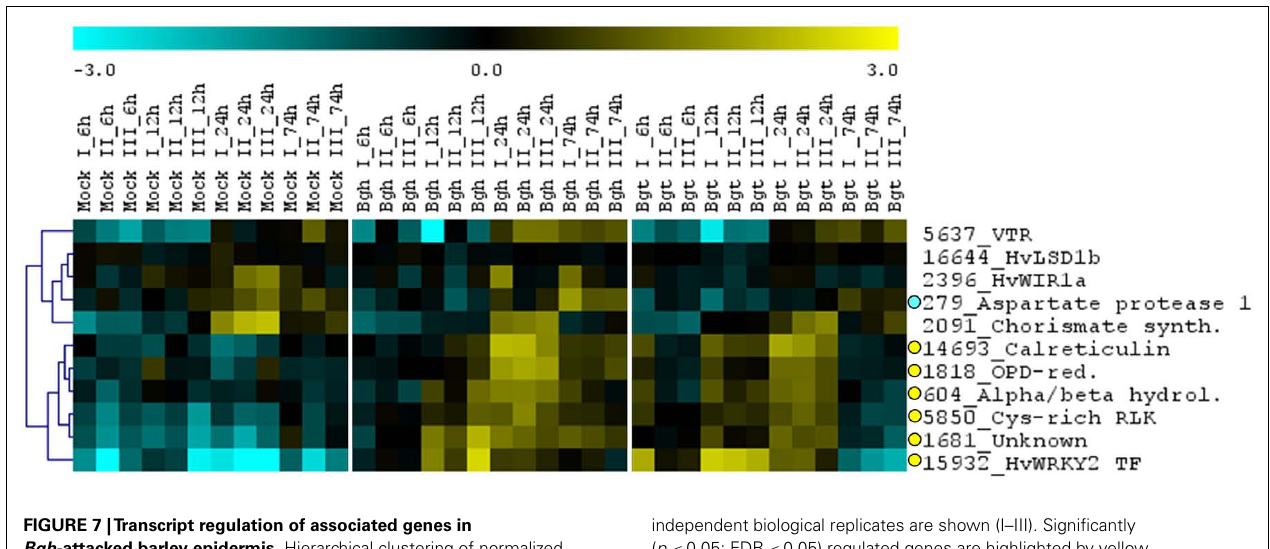
FIGURE 7 |Transcript regulation of associated genes in Bgh -attacked barley epidermis. Hierarchical clustering of normalized signal intensities after log(2)-transformation and median centering per transcript. RNA was derived from peeled epidermis after inoculation with Bgh or the wheat powdery mildew (Bgt). Data from three